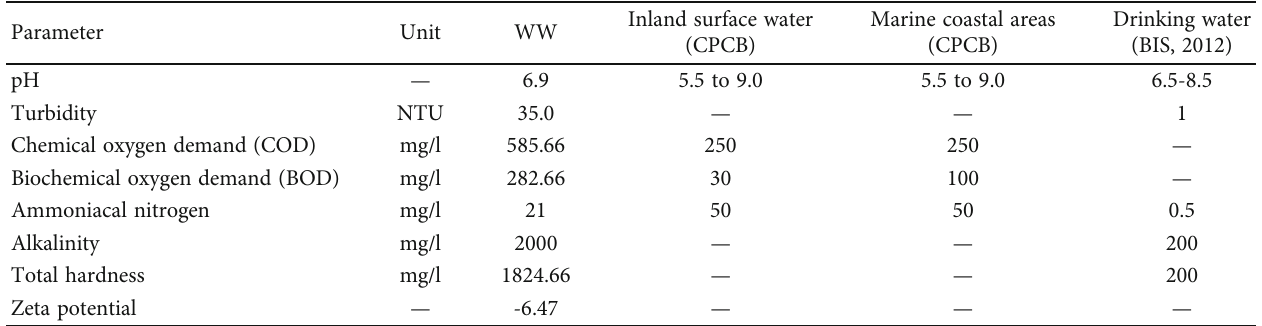
Table 1: The physicochemical analysis of wastewater and discharge standards (CPCB and BIS,